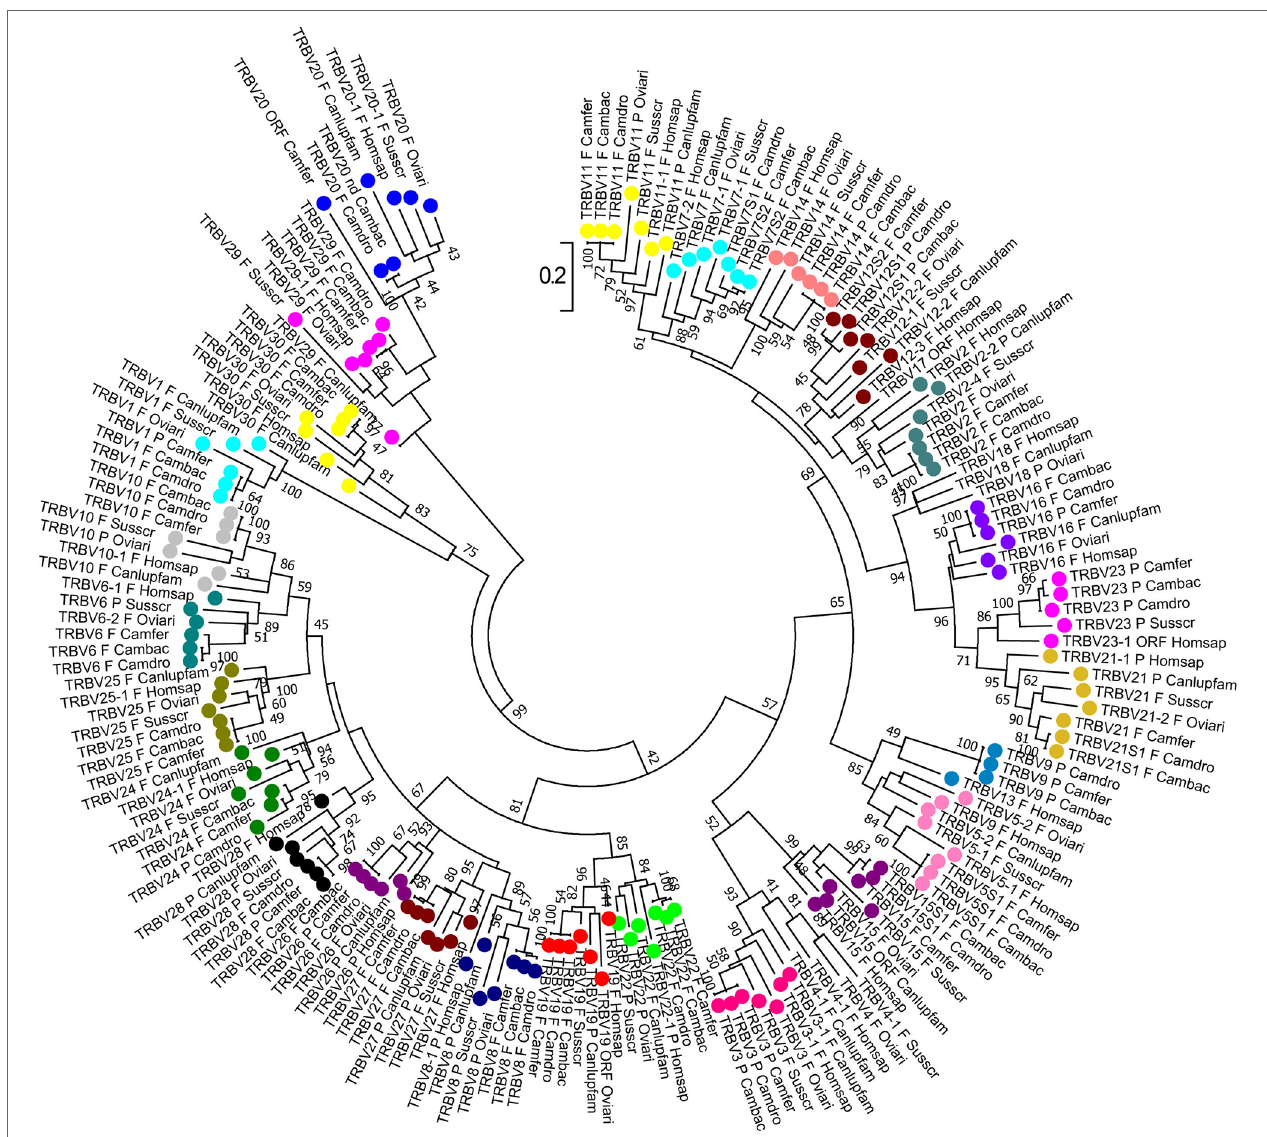
FIGURE 4 | Phylogenetic tree of the dromedary, wild, and domestic Bactrian camel, human, dog, sheep, and pig TRBV gene sequences. The sequences of the human, dog, sheep, and pig TRBV genes were retrieved from the IMGT database (http://www.imgt.org/), whereas the camel TRBV gene sequences derived from Antonacci et al., 2019. The nucleotide sequences of the V-REGION were combined by adopting two selection criteria: (1) only potential functional and in-frame pseudogenes (excepted for human TRBV1) were included; and (2) only one gene for each of the subgroups was selected for each species. The evolutionary analysis was conducted in MEGA7 (Kumar et al., 2016). The evolutionary history was inferred by using the Maximum Likelihood method based on the Tamura- Nei model (Tamura and Nei, 1993). The tree is drawn to scale, with branch lengths measured in the number of substitutions per site. The analysis involved 181 nucleotide sequences. Codon positions included were 1st+2nd+3rd+Noncoding. All positions containing gaps and missing data were eliminated. The different colours highlight the distribution of the phylogenetic groups corresponding to the 26 camel TRBV subgroups. The gene functionality according to IMGT rules (F, functional; ORF, open reading frame; P, pseudogene) is indicated; nd indicates that the nucleotide sequence of the gene is incomplete and its functionality cannot be defined. The IMGT 6-letter for species (Homsap, Susscr, Oviari, Camdro, Camfer, and Cambac) and 9-letter for subspecies (Canlupfam) standardized abbreviation for taxon is